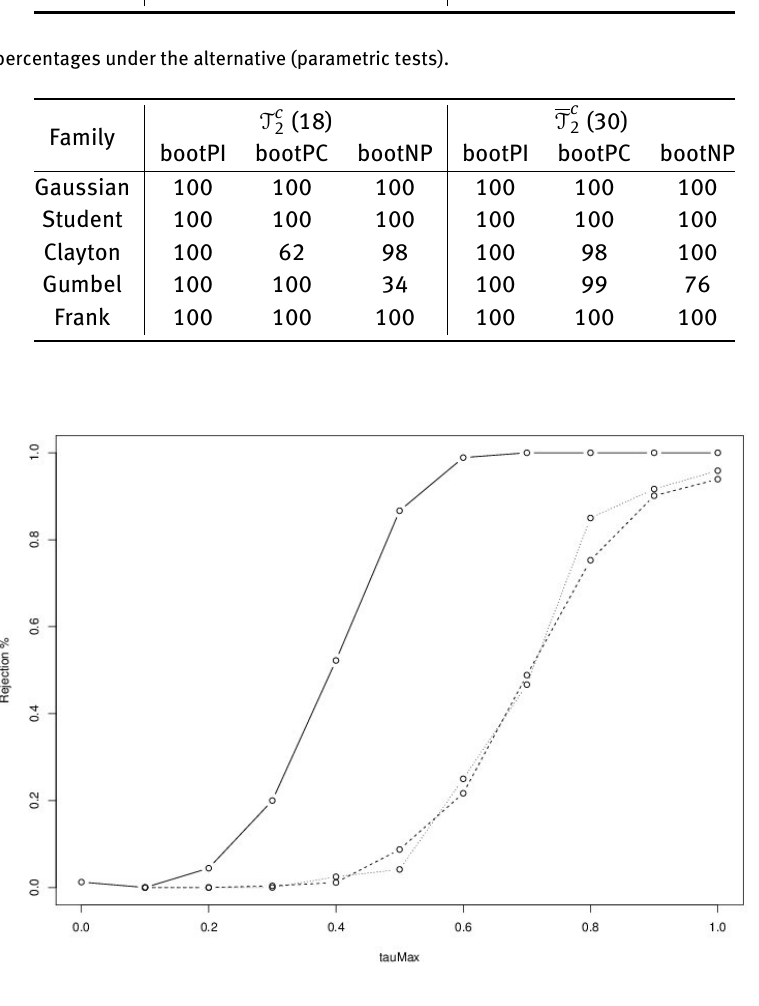
Figure 1: Rejection percentages for the statistics I χ (13) as a function of τ max : we use the gaussian copula, with a conditional parameter θ ( x ) calibrated such that the conditional Kendall’s tau τ ( x ) satisfies τ ( x ) = τ max · Φ ( x ) . Solid line: bootNP. Dashed line : bootPseudoInd. Dotted line :